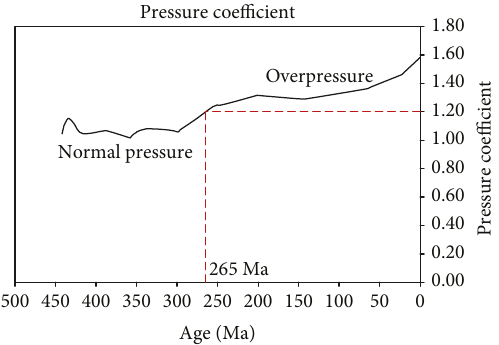
Figure 8: The pressure coe ffi cient evolution of the Lianglitage Formation (O ) in Well 3